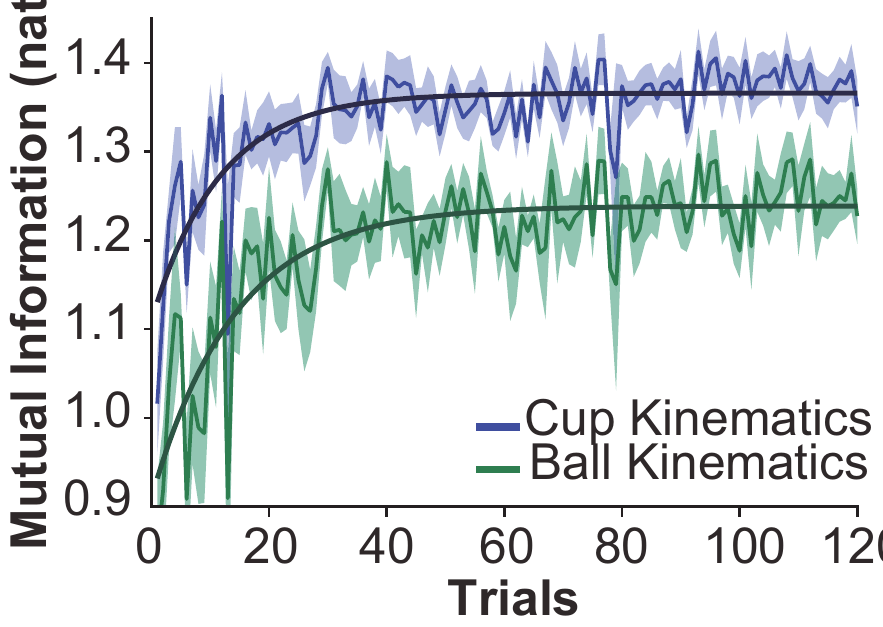
Fig 4. Predictability of cup and ball dynamics measured via mutual information : Mutual information between F inter (t) and cup kinematics averaged across subjects over trials is shown in blue. Parameters of the exponential fit were: A = 0.26, τ = 11.54, B = 1.11, and R 2 = 0.65. Mutual information between F inter (t) and ball kinematics averaged across subjects over trials is shown in green. Parameters of the exponential fit were: A = 0.33, τ = 14.14, B = 0.91, and R 2 =